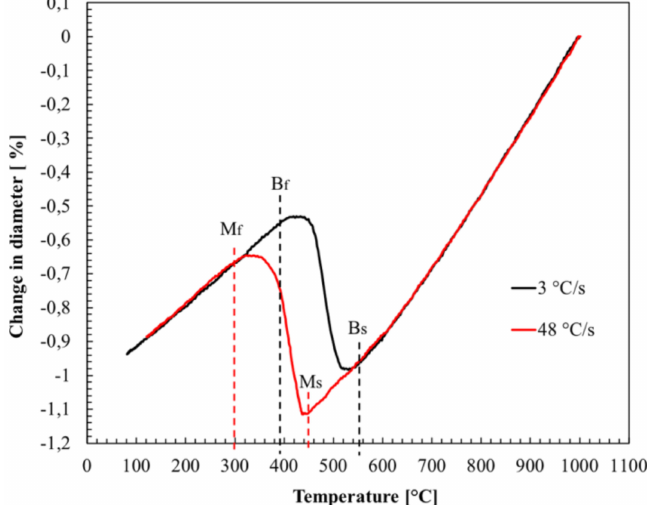
Figure 2. Dilatometry curves of DQ steel from CCT Gleeble tests without